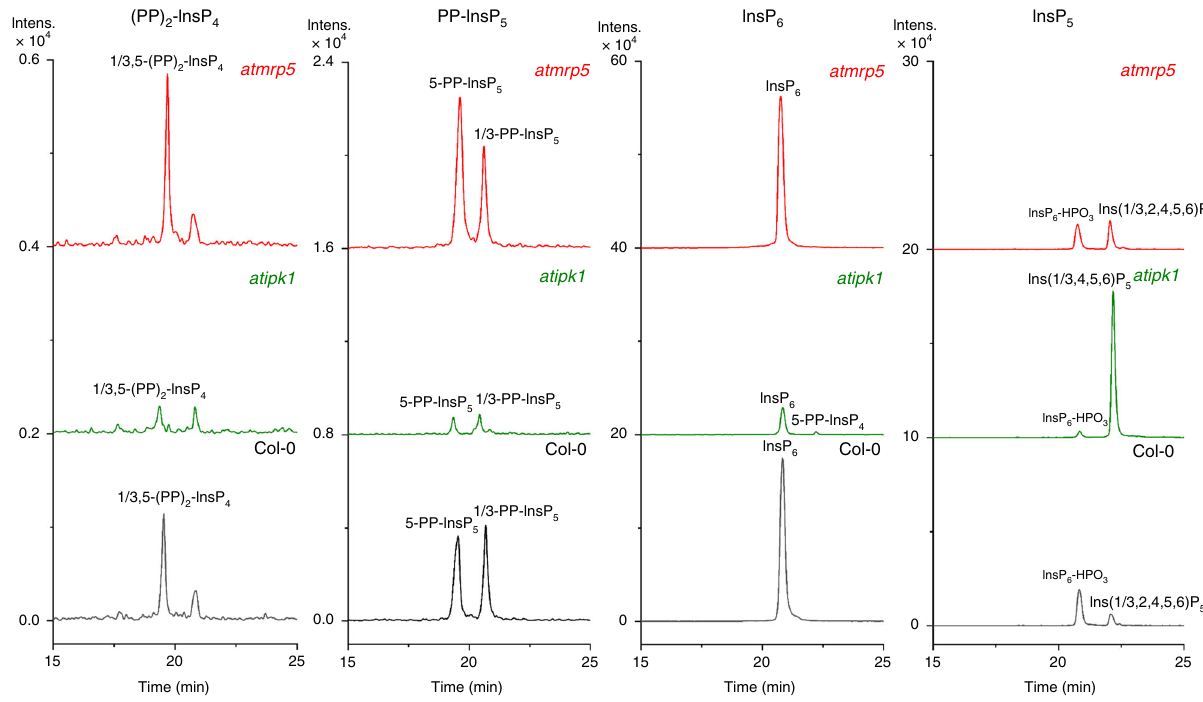
Fig. 3 CE-ESI-MS analysis of PP-InsP in Arabidopsis thaliana shoots. Shoot extracts from wild type (Col-0), atipk1 , and atmrp5 mutant plants were analyzed to assess the presence of InsP 5 , InsP 6 , 5-PP-InsP 5 , and 1,5-(PP) 2 -InsP 4 . InsP 5 isomer composition differed in the different genotypes: Ins(1/ 3,2,4,5,6)P 5 is present in Col-0 and the mrp5 mutant, whereas Ins(1,3,4,5,6)P 5 was detected in atipk1 plants. A decreased level of 1,5-(PP) 2 -InsP 4 , 5-PP- InsP 5 , 1-PP-InsP 5 , InsP 6 , and increased level of 5-PP-InsP 4 and Ins(1,3,4,5,6)P 5 were observed for the atipk1 mutant. In the atmrp5 mutant, levels of 1,5- (PP) 2 -InsP 4 and 5-PP-InsP 4 were increased. The electropherograms are representative of independent biological duplicates giving comparable results. Source data are provided as a Source Data fi